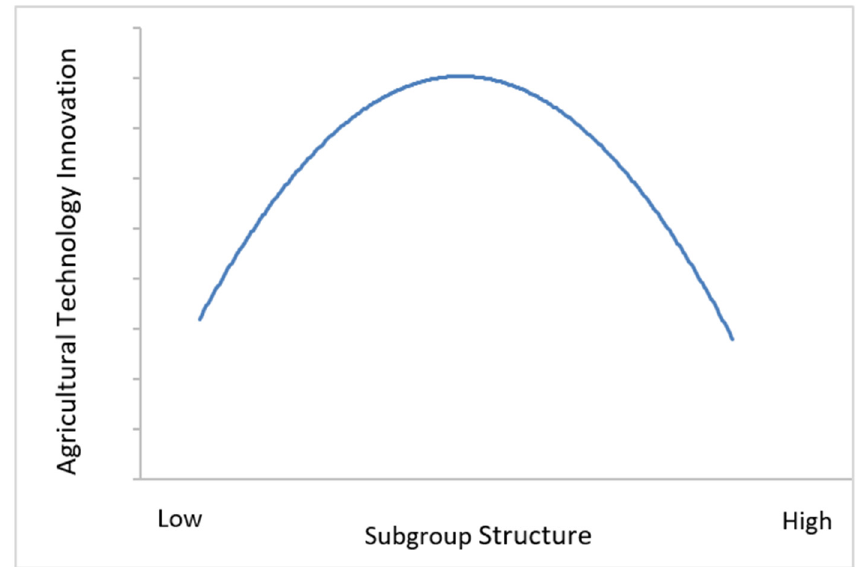
Figure 2. The Effect of the Subgroup Structure on Agricultural Technological Innovation. (3) The moderating role of positional embeddedness.